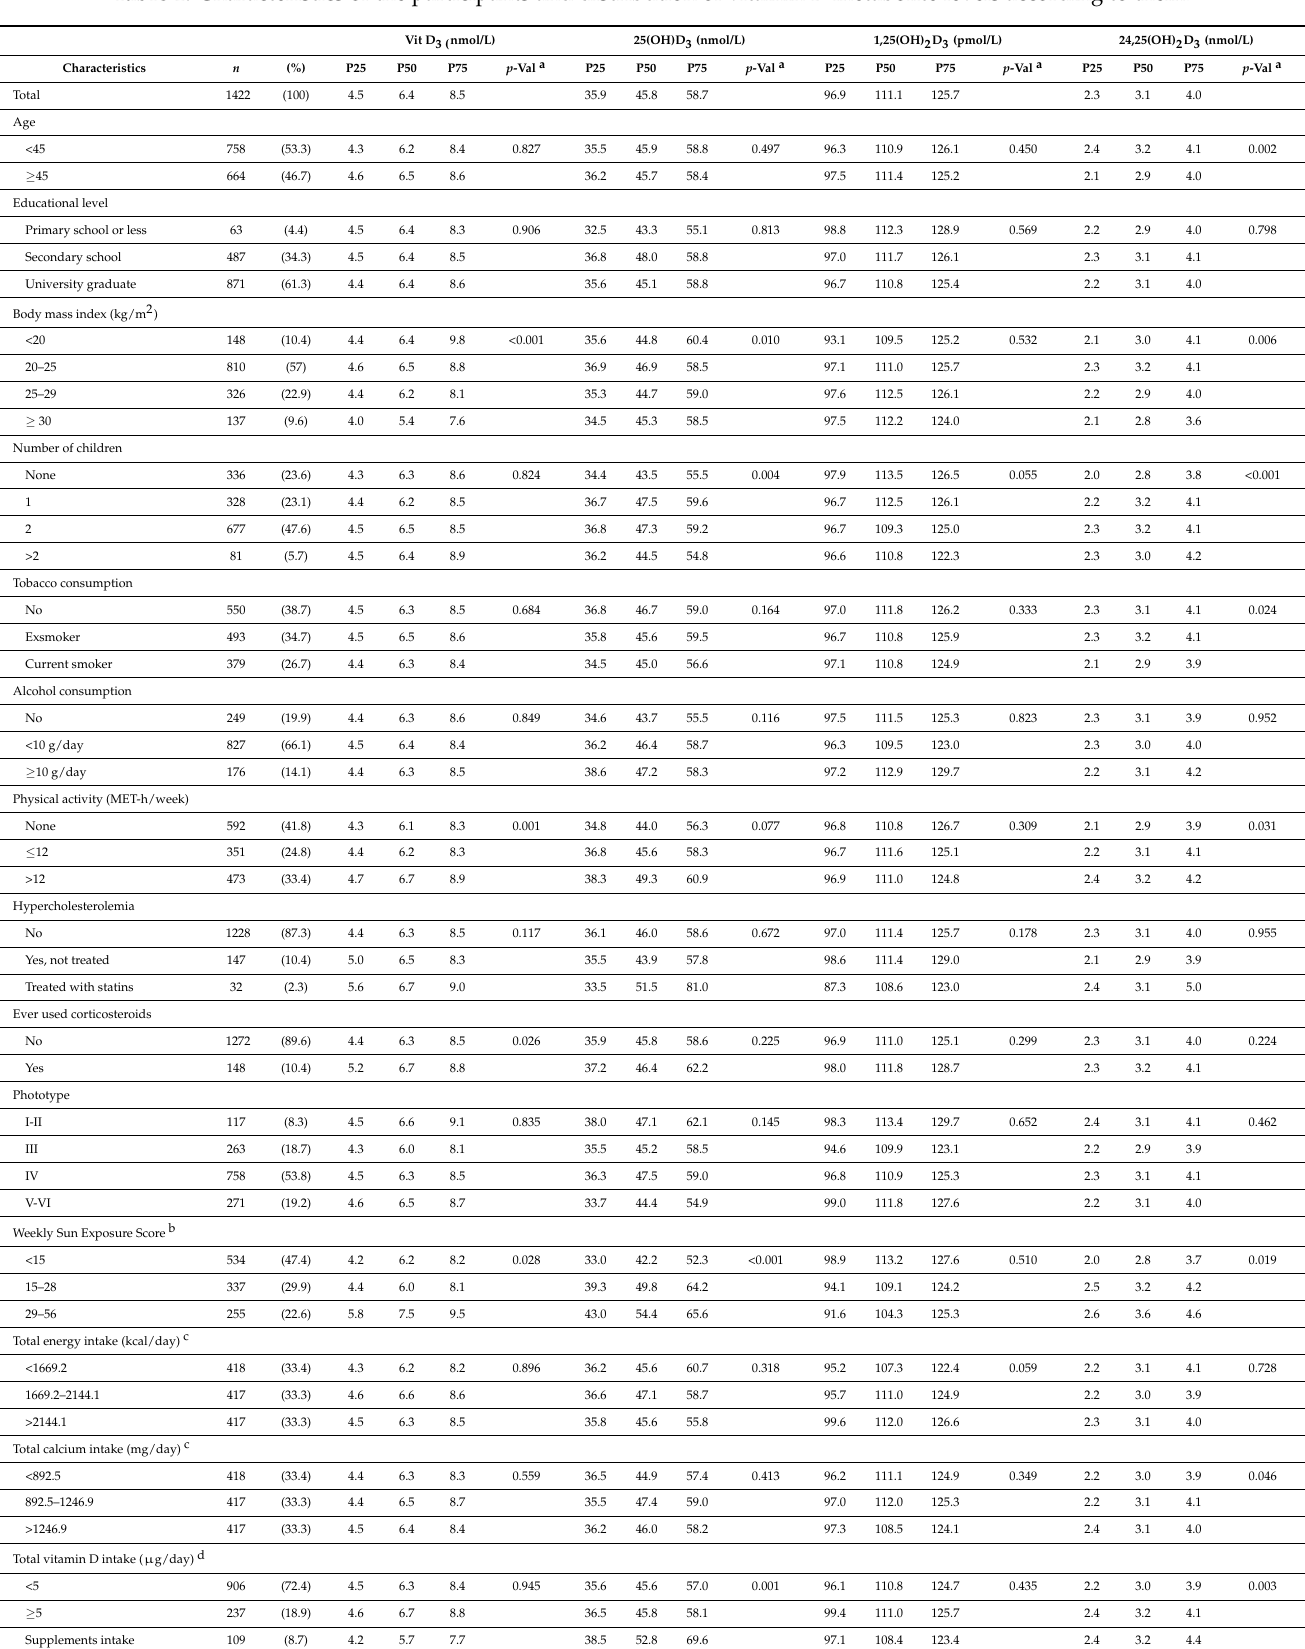
Table 1. Characteristics of the participants and distribution of vitamin D metabolite levels according to